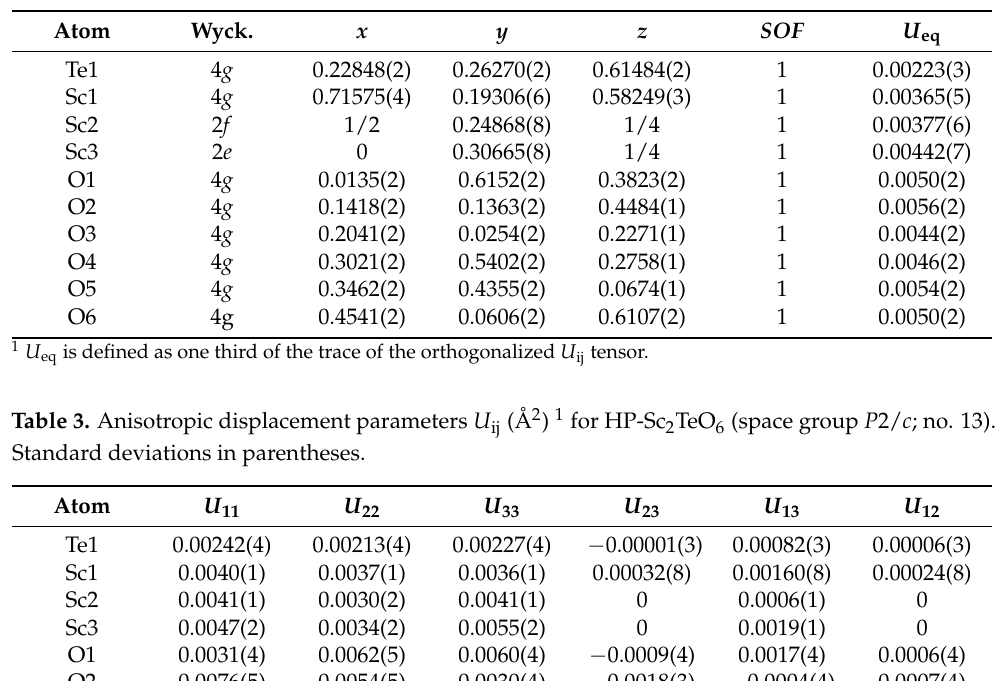
Table 2. Atomic coordinates, Wyckoff positions, site occupancy (s. o. f.) and equivalent isotropic